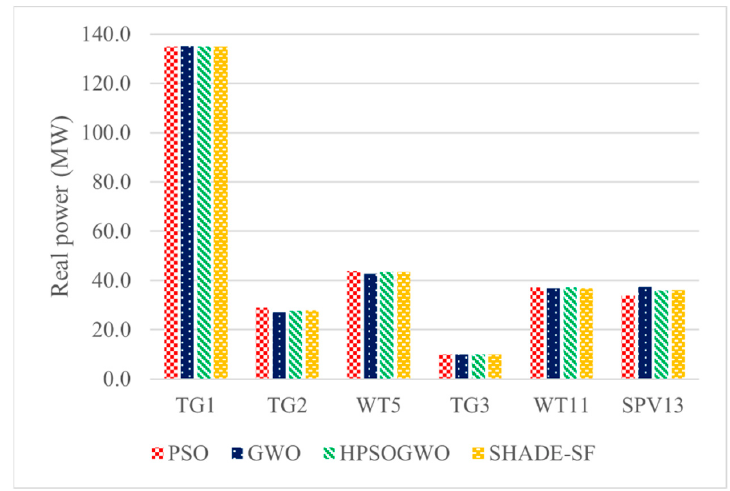
Figure 21. Generators real power comparison (Case 4).